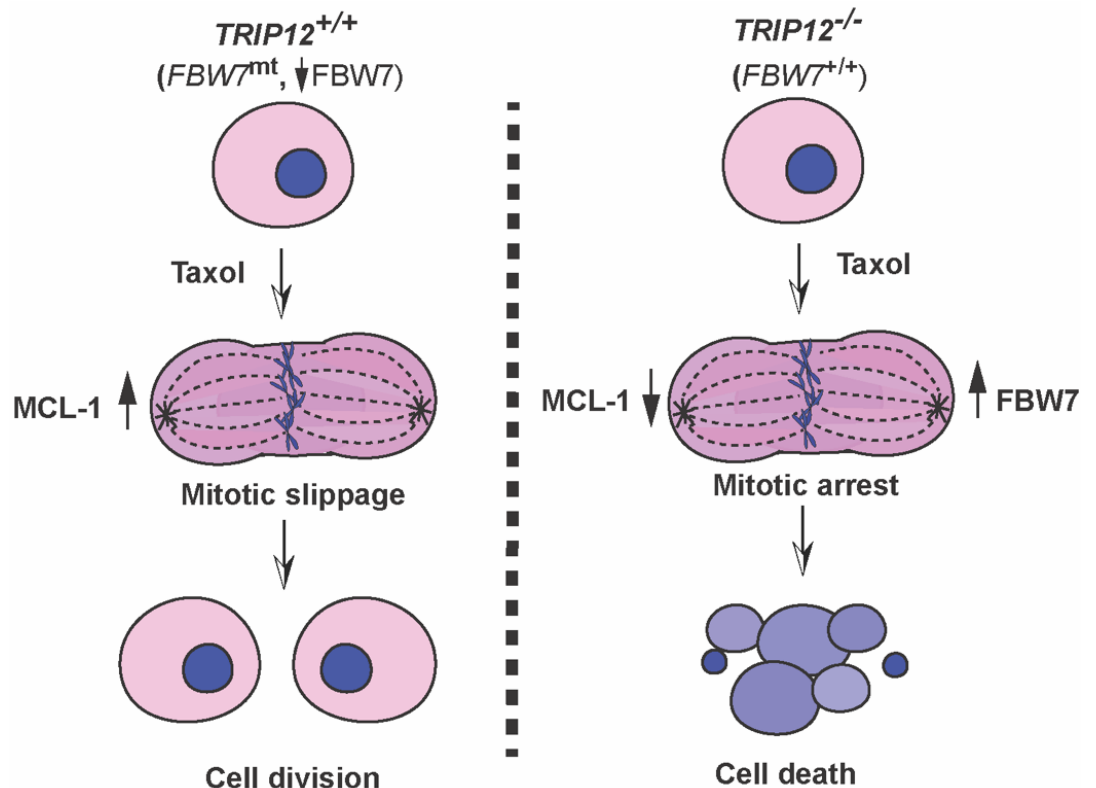
Figure 7. TRIP12 inhibits mitotic arrest in response to Taxol.